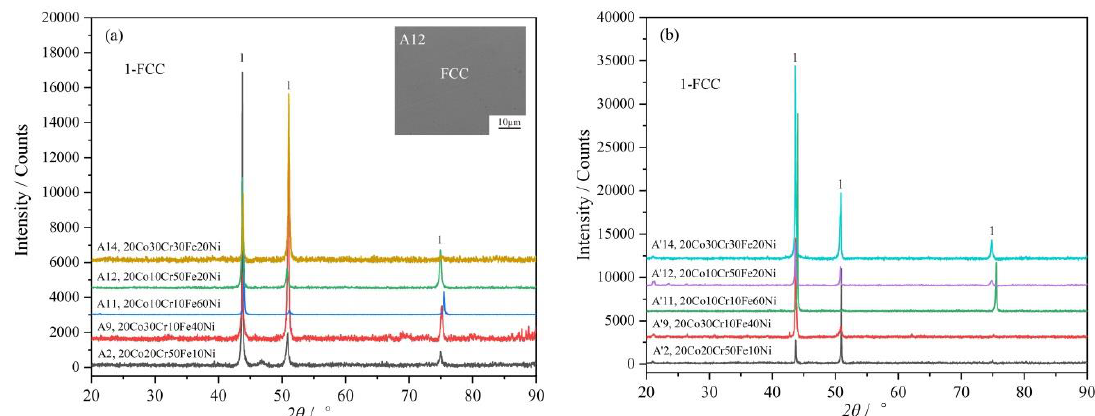
Figure 2. XRD patterns of some 20Co-Cr-Fe-Ni alloys which have single FCC phase in ( a ) as-cast state and ( b ) after being annealed at 1000 °C for 30 days. The inset figure is the BSE micrograph of the alloy A12.